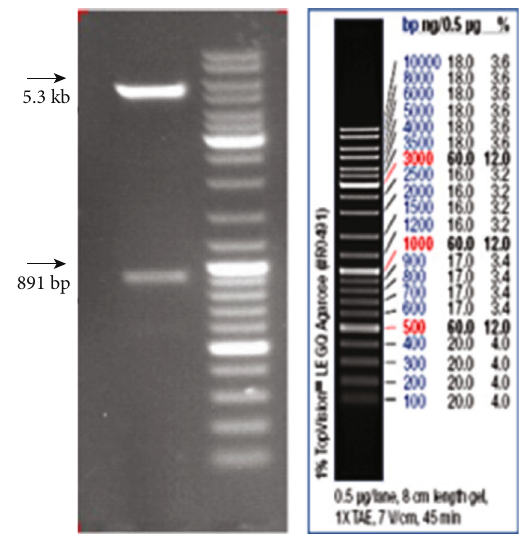
Figure 1: Recombinant Ag85A gel